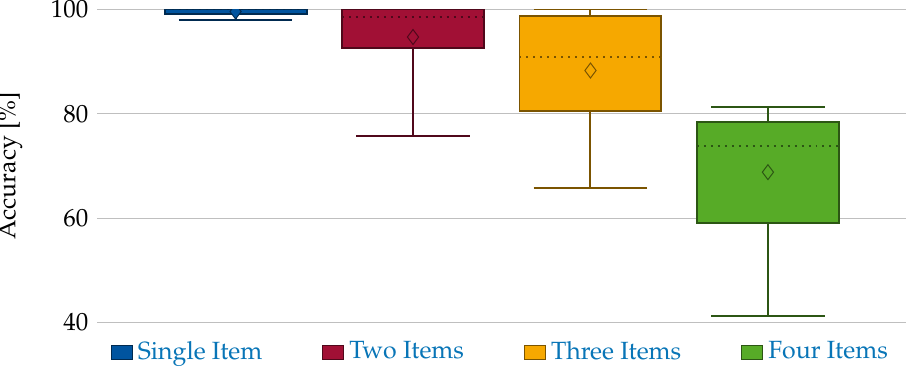
Figure 13. Accuracy measures and variances depending on the number of items in the